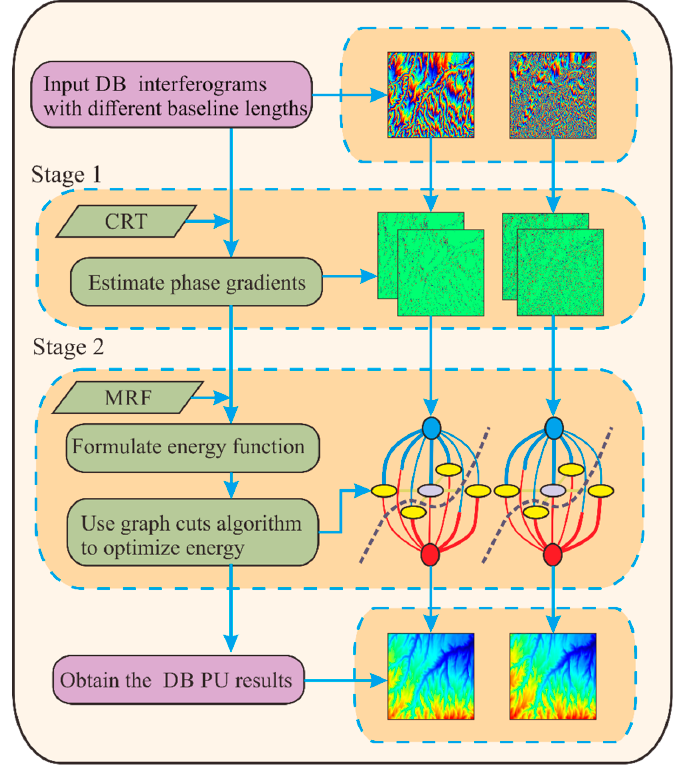
Figure 2. Schematic representation of the proposed TSPA-PUMA method.